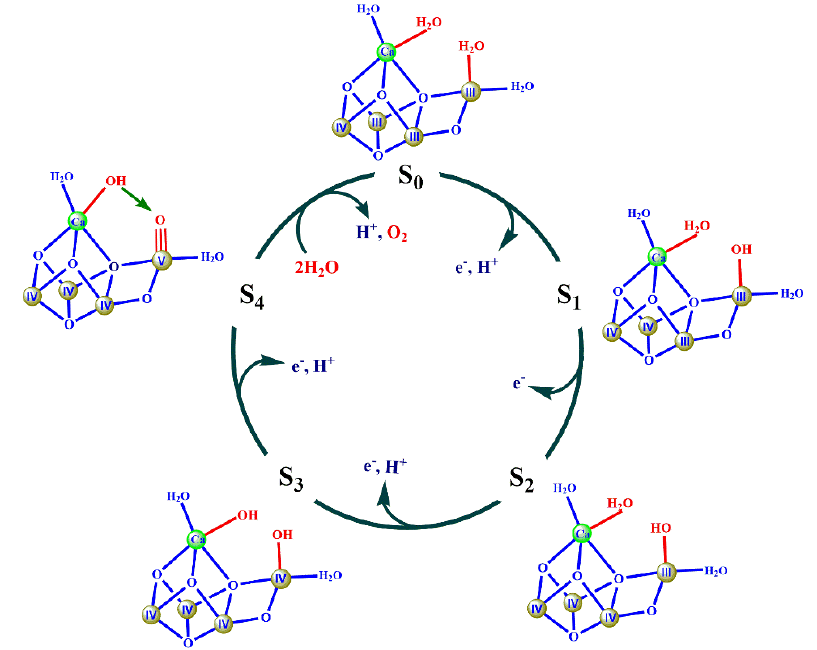
Figure 3. One possible mechanism for the water-splitting reaction by OEC suggested by Barber’s group [77]. Significant changes during the catalytic cycle are given in a red color. Mn and Ca are shown in brown and green, respectively. Roman numerals indicate the oxidation states of manganese ions. For clarity, all protein ligands of the OEC are omitted.